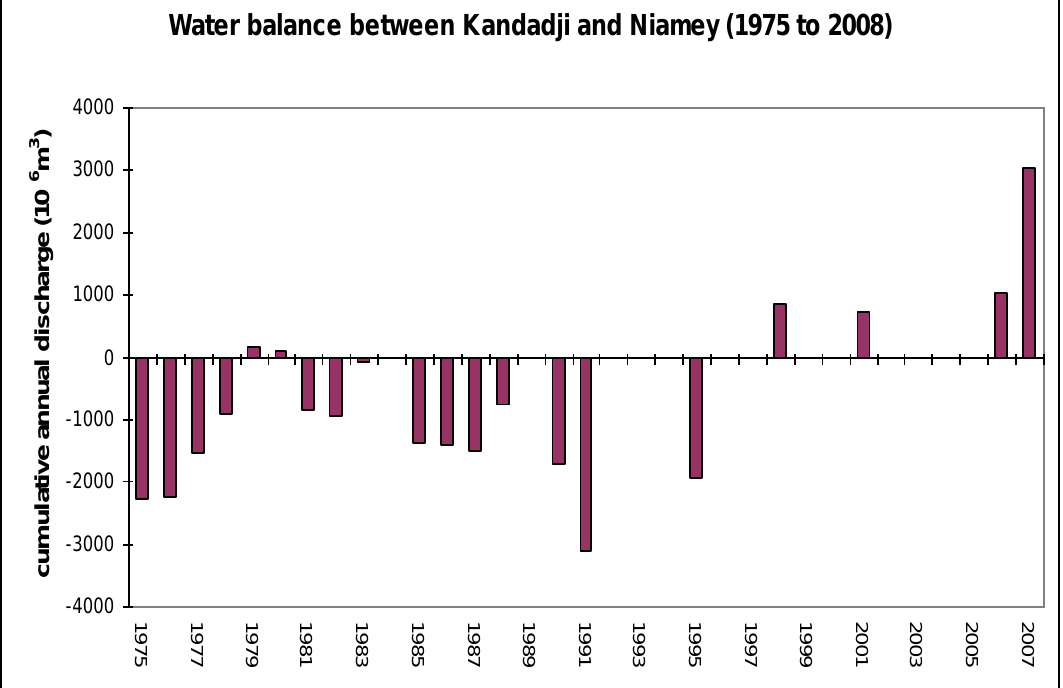
Figure 5. Evolution of the remaining water balance between Kandadji and Niamey from 1975 to 2008, once the discharges of the two main tributaries between both stations, the Dargol and the Sirba, were removed (see Figure 3). Years without column are missing